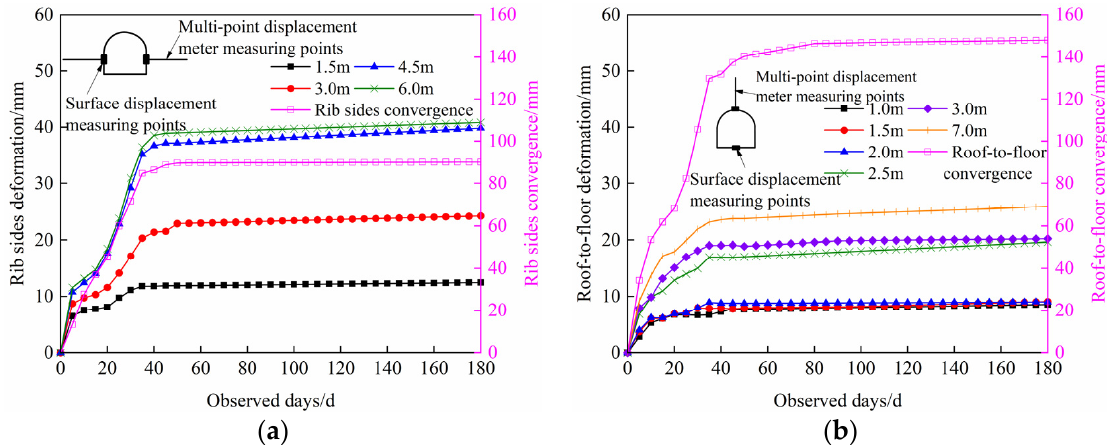
Figure 14. Deformation and convergence of roadway surrounding rock. ( a ) Roadway rib. ( b ) roadway roof and floor.